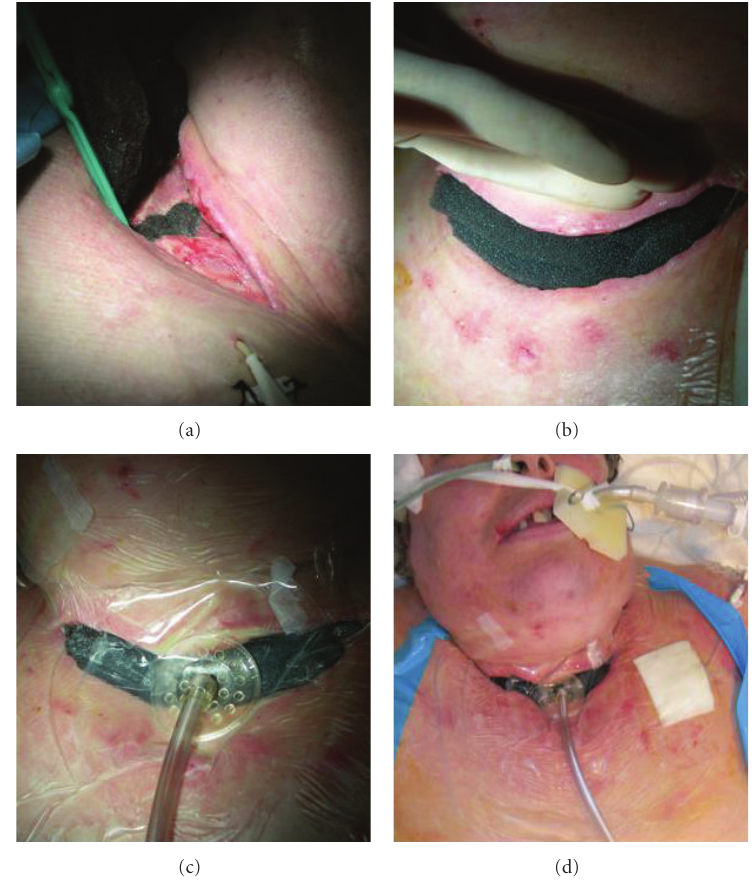
Figure 2: Vacuum-assisted closure